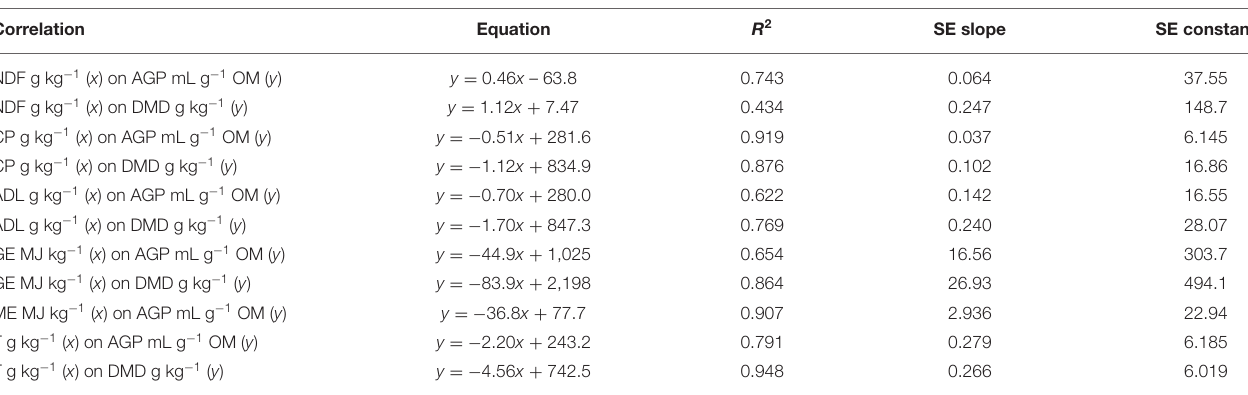
TABLE 5 | Correlations obtained by type II linear regression analysis. Correlation Equation R 2 SE slope SE